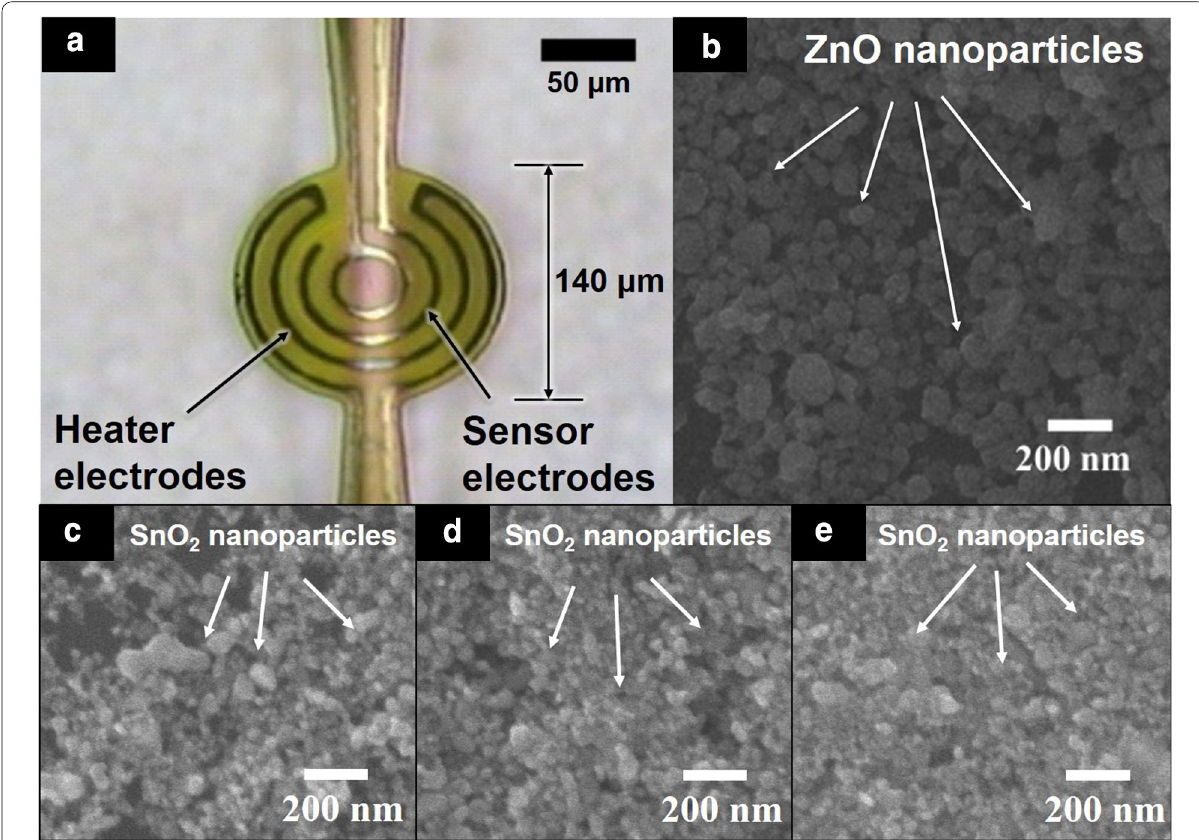
Fig. 3 a Optical image of the fabricated sensor platform. Scanning electron microscope image of b ZnO NPs/CoPP, c SnO 2 NPs/CoPP, d SnO 2 NPs/ ZnPP, and e SnO